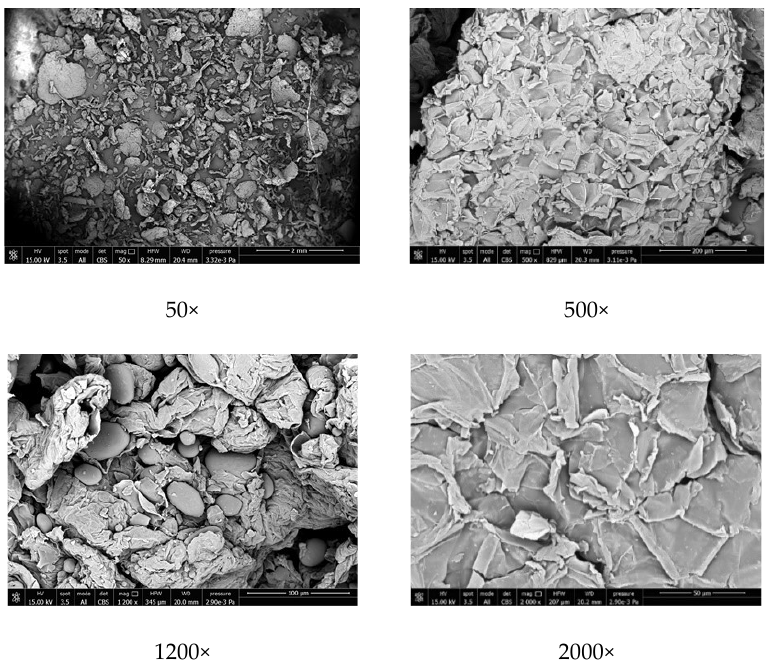
Figure 2. Scanning electron microscopy (SEM) images of the potato pulp powder (PPP) at the magnifications indicated.